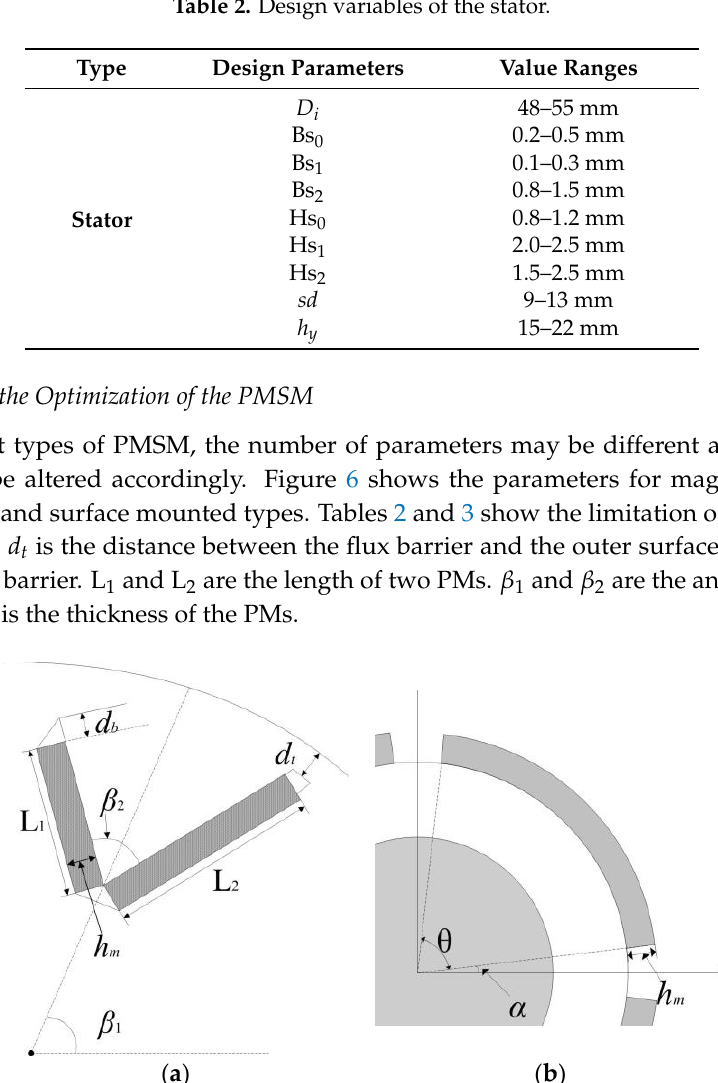
Table 2. Design variables of the stator.